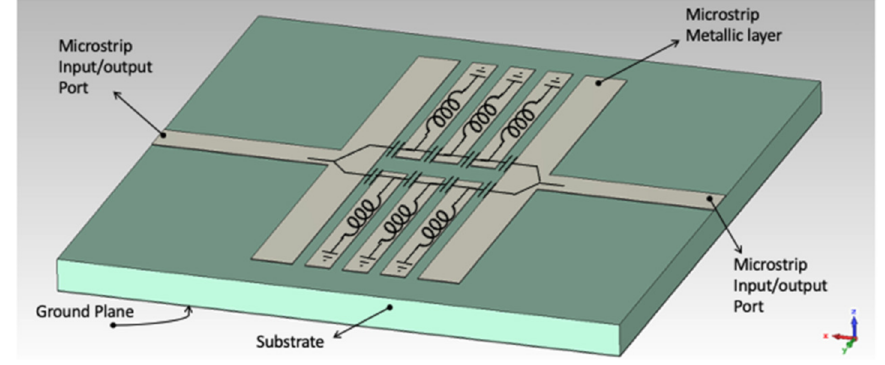
Figure 1. Equivalent circuit model of the proposed structure around the λ /2 stubs resonances of the capacitively coupled microstrips with a schematic of the MIMN around the microstrip stub resonant